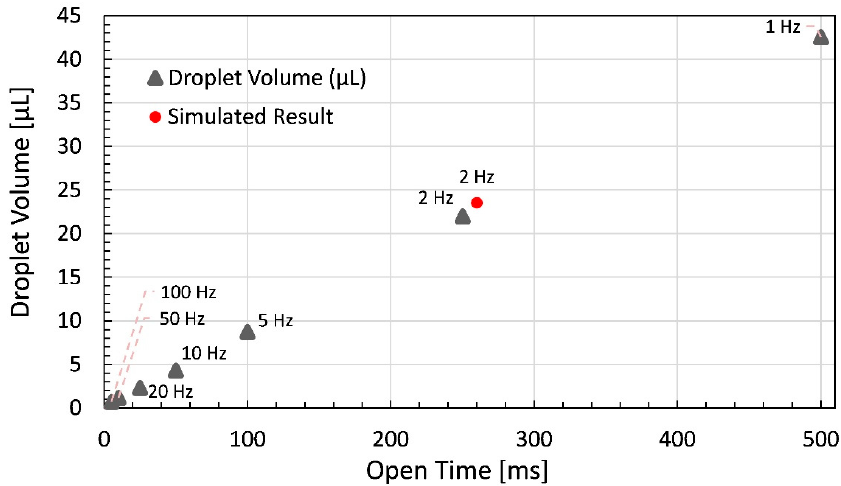
Figure 11. Droplet volume of dispensed droplets plotted against open time with respect to respective frequency in addition to simulation result at 2 Hz frequency and 260 ms open time.